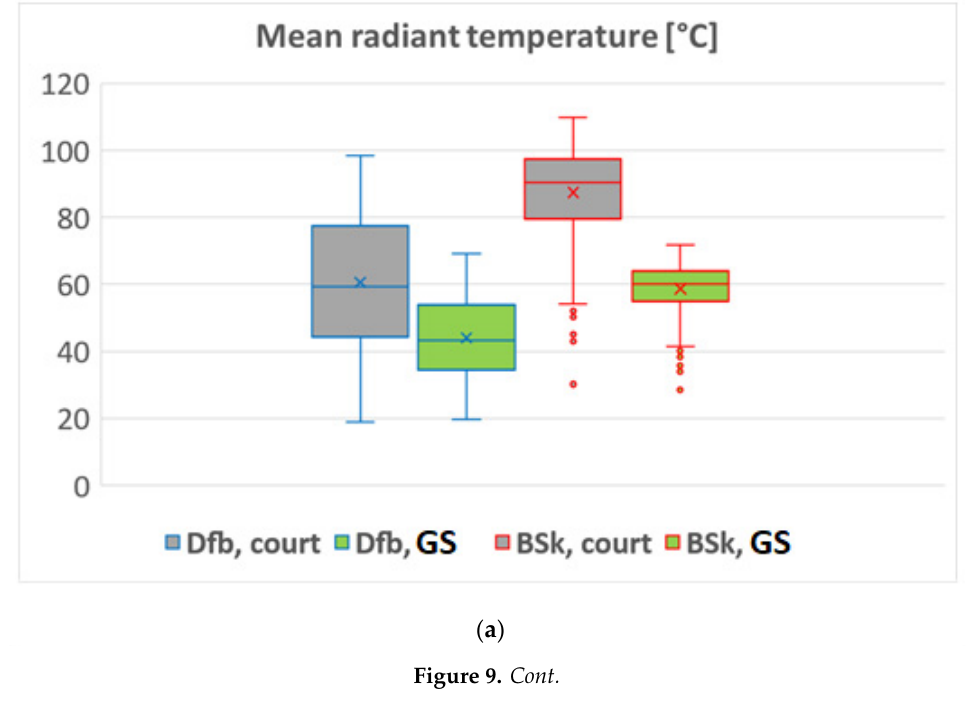
( b ) Figure 9. The reduction of ( a ) T mrt and ( b ) UTCI by the GS application in the courtyard. Results of the simulation for two cities: Poznan, Poland–Dfb acc. To Köppen and Murcia, Spain–BSk acc. To Köppen. Analyzed period: July and August (typical meteorological year) between 10:00 and 18:00. 5. Discussion 5.1. The GS Need In dry and hot climate people, especially the elderly, prefer to stay at home if their urban environment is not adapted to their needs, i.e., there is a lack of cool spaces, where they could restore their comfort. The increasingly popular and very effective solution for cooling indoor spaces is air ‐ conditioning [71]. However, long exposure to the specific thermal environment has an impact on human physiology [72]. This lifestyle leads to both decrease of human comfort resilience [73] and an